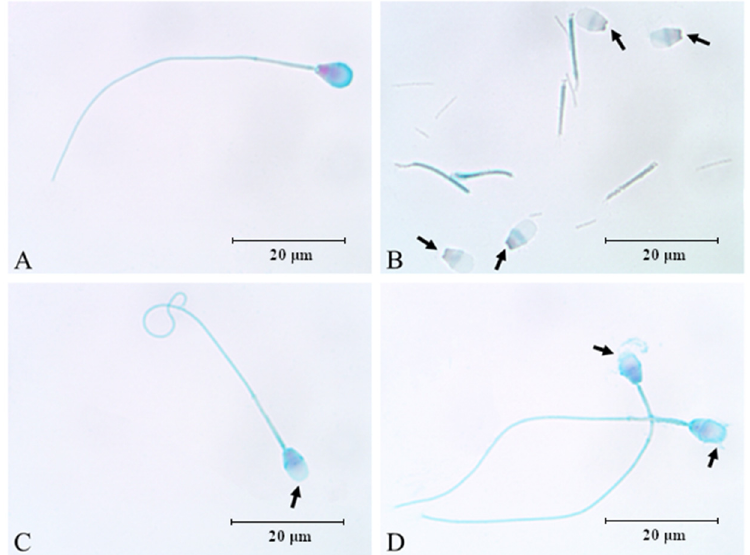
Figure 1. Morphological changes in dog ( Canis lupus familiaris ) cauda epididymal spermatozoa (n = 15) after sonication stained with the Spermac stain (1000× magnification in light microscope). ( A )—normal epididymal sperm; ( B )—damaged epididymal sperm, with detached head and detached tail; ( C )—damaged epididymal sperm showing acrosome loss; ( D )—epididymal sperm showing damaged acrosomal membrane. Arrows show the exact sperm